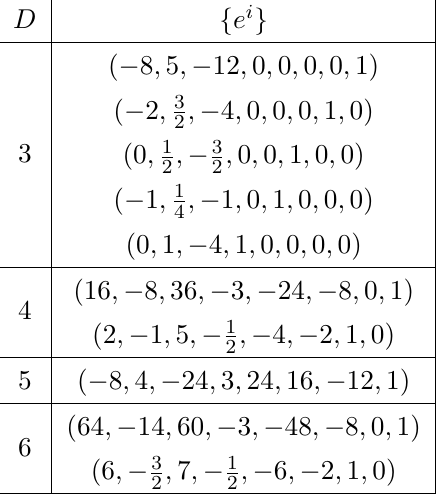
Table 1. Dimension-specific solutions of cubic ETQT